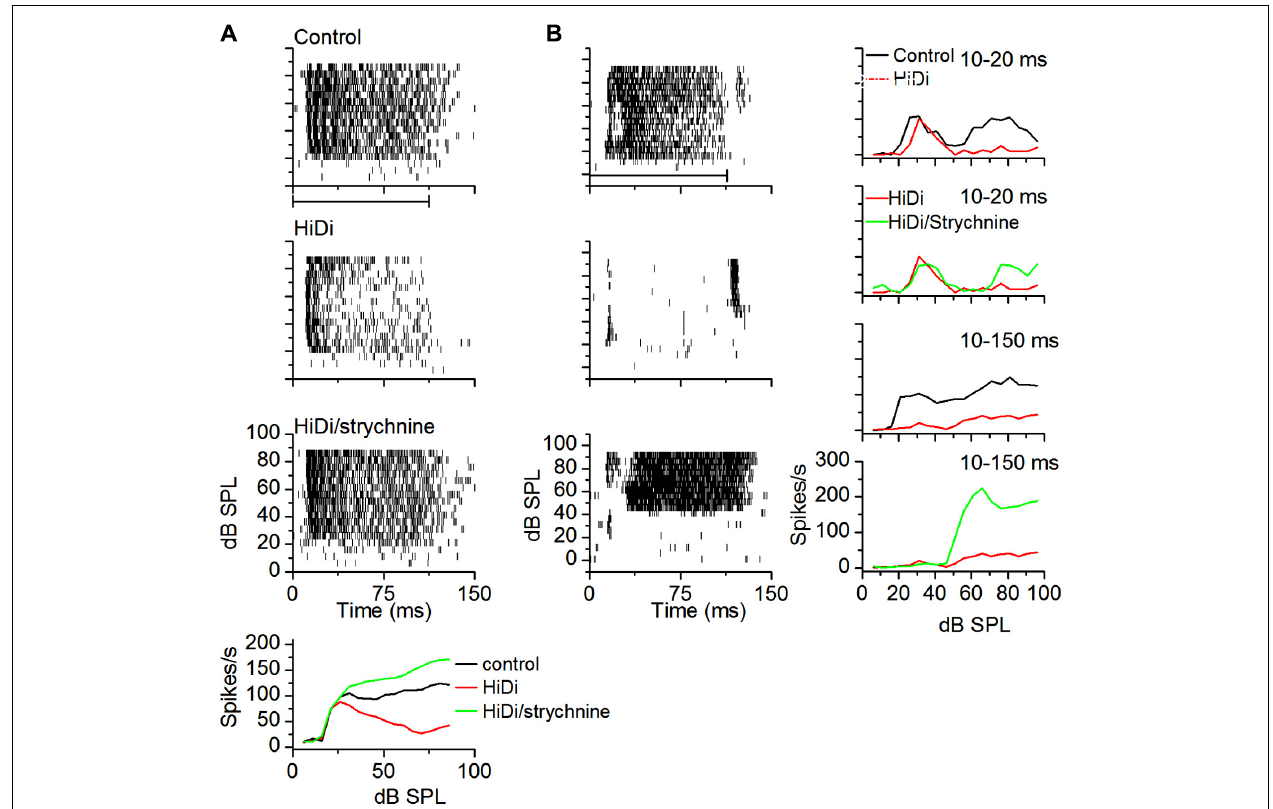
FIGURE 9 | HiDi does not block ascending monosynaptic glycinergic responses in vivo . (A) Top three panels: spike rasters in control, 2.5 HiDi and 2.5 HiDi + 8 μ M strychnine. Firing rates are reduced in HiDi but increased in HiDi/strychnine.The glycinergic input therefore inhibited firing rate in the presence of HiDi (the middle panel).The firing rate during the tone is due to a balance between (net) local excitation and ascending inhibition. Bottom: the RIF shows that the glycinergic input, which is an ascending inhibitory input, is not blocked by HiDi, thus HiDi preserves ascending lemniscal inputs. (B) A second example of a glycinergic input remaining active in the presence of HiDi. A neuron receiving ascending monosynaptic inhibition also receives local excitatory feedback. Left column: spike rasters in a cell with